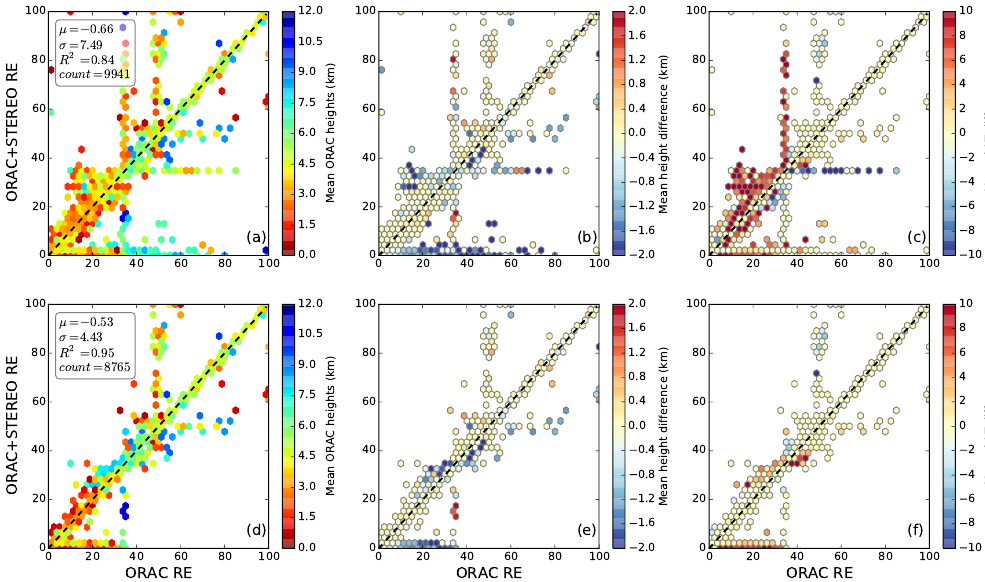
Figure 11. Joint histograms of RE as retrieved by ORAC and by ORAC + stereo. Plots (a–c) show the samples for all single-layer clouds over water (number of layers determined by CALIOP and open water determined by AMSR-E). Plots (d–f) show the subset of the sample where the ORAC and ORAC + stereo phases are in